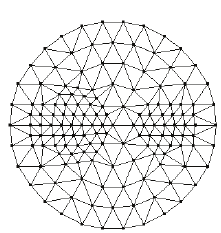
Figure 6: Adaptively refined mesh.